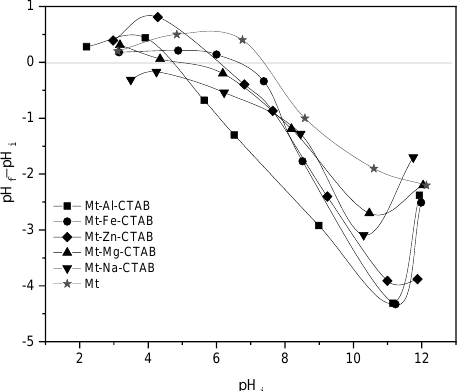
Figure 4. The pHpzc of Mt and modified organo-clays. 199